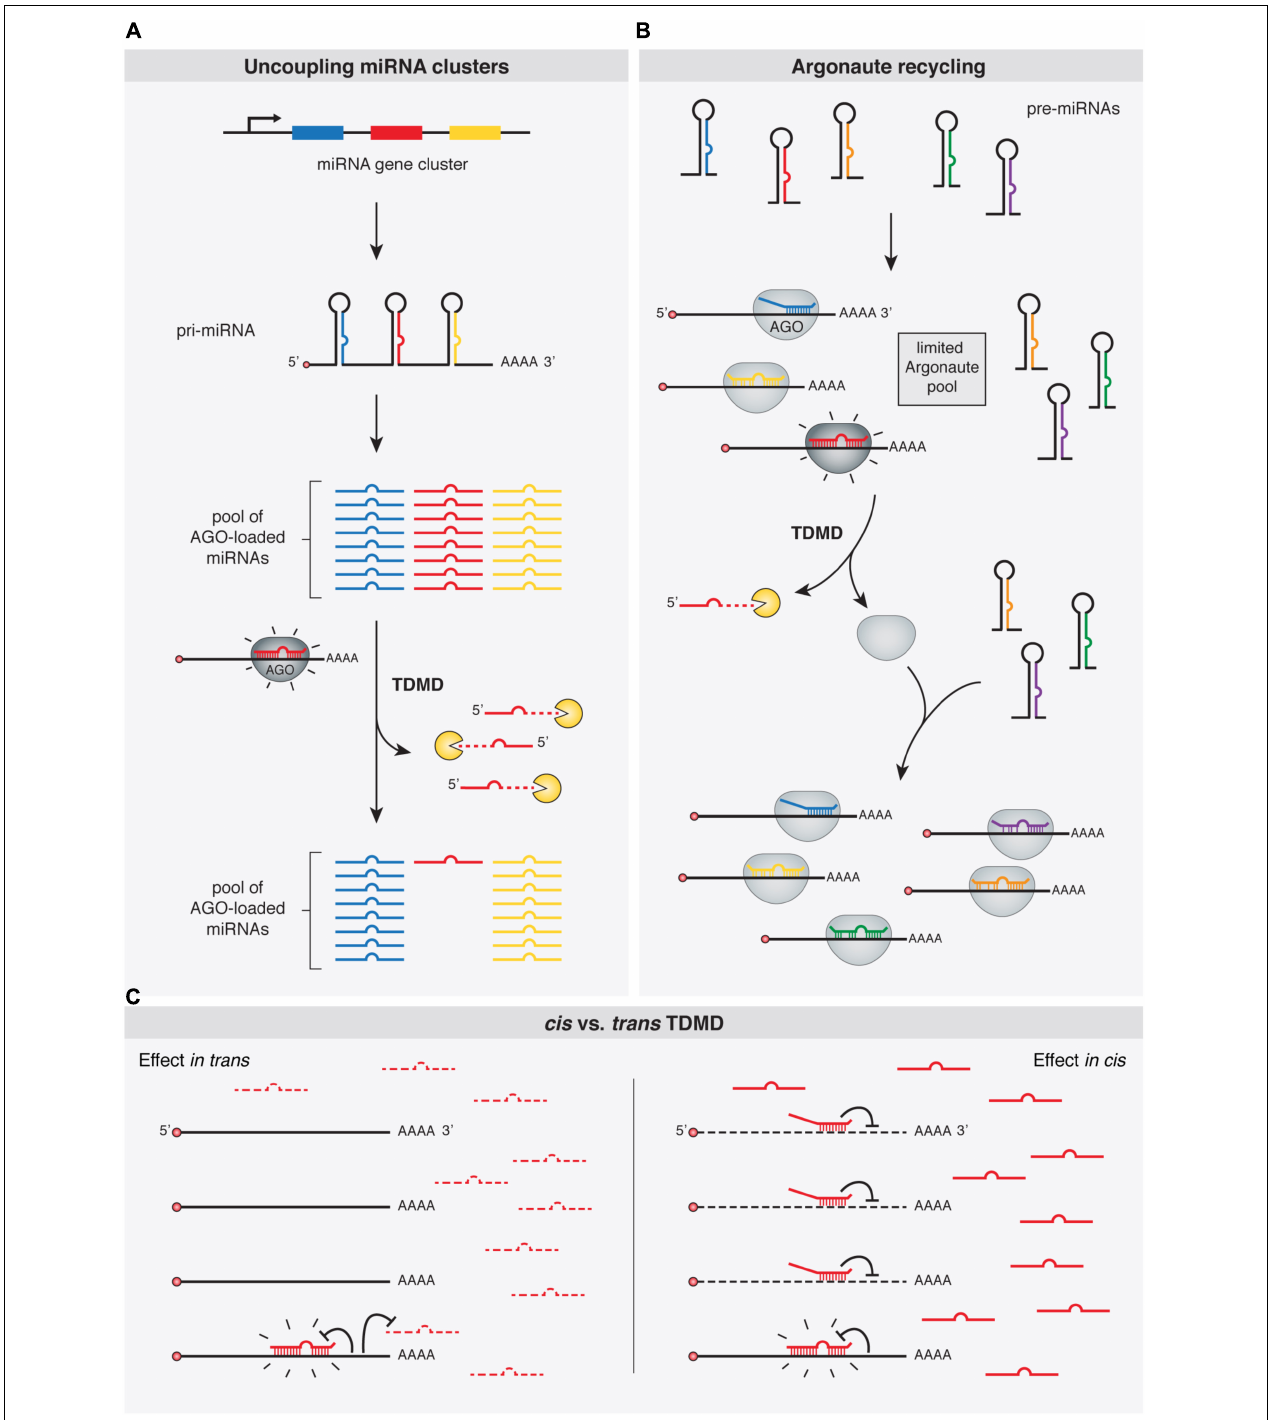
FIGURE 4 | Functional implications of TDMD. TDMD might control and diversify miRNA expression patterns by means of: (A) allowing expression of specific miRNA family members from single gene clusters, e.g., in a tissue- or developmental time-specific manner; (B) promoting the recycling of Argonaute (Ago) proteins and thus the loading of newly synthesized miRNAs; or (C) Right panel: avoiding miRNA silencing in cis , e.g., under circumstances where TDMD-competent target RNAs might be too scarce to globally affect miRNA abundance in trans , but effective enough to trigger TDMD in cis and becoming immune to miRNA silencing (in contrast to the left panel where an abundant target RNA would additionally deplete a specific miRNA in trans globally in the cell, as in A ). Shine emphasis is shown on “TDMD-primed” Ago-miRNA-target complexes.